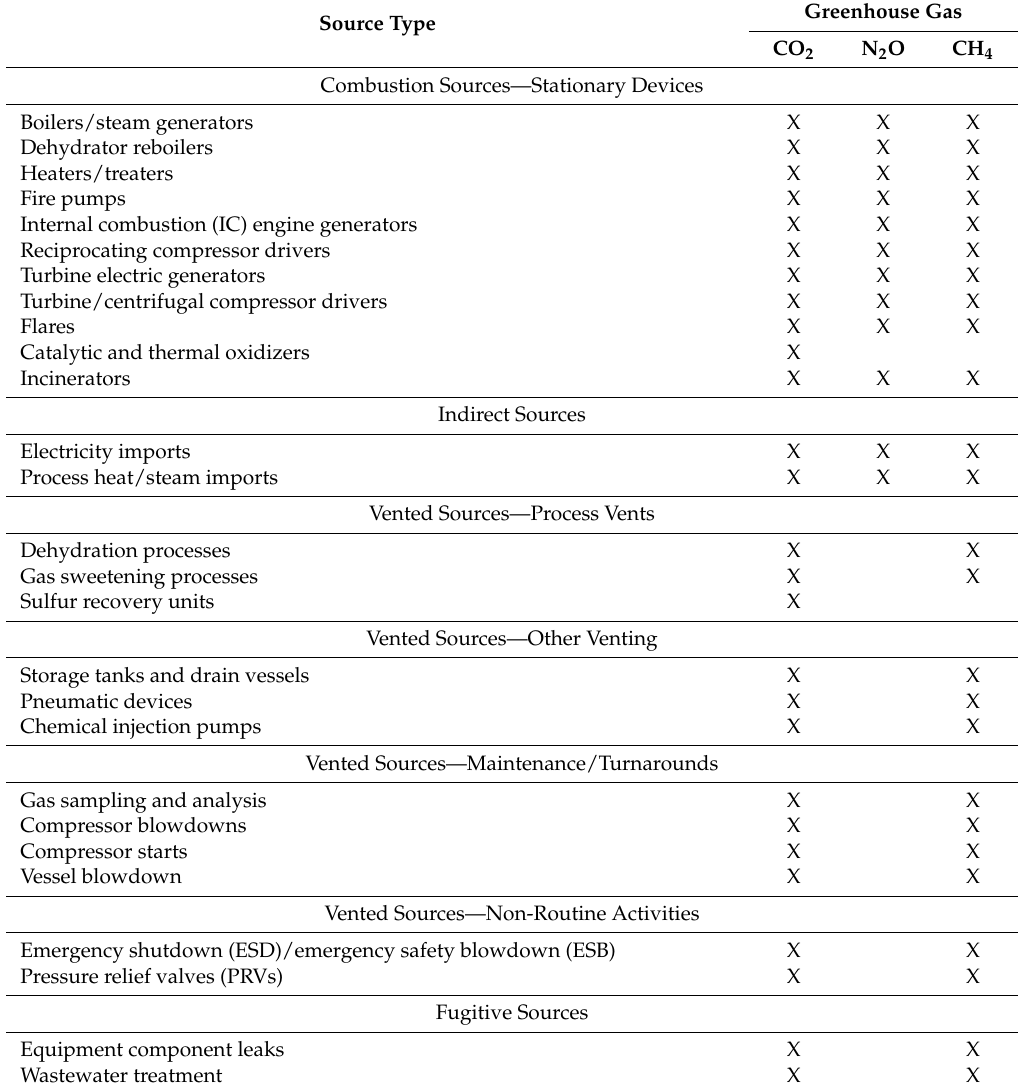
Table 6. Potential Greenhouse Gas Emission Sources in Processing